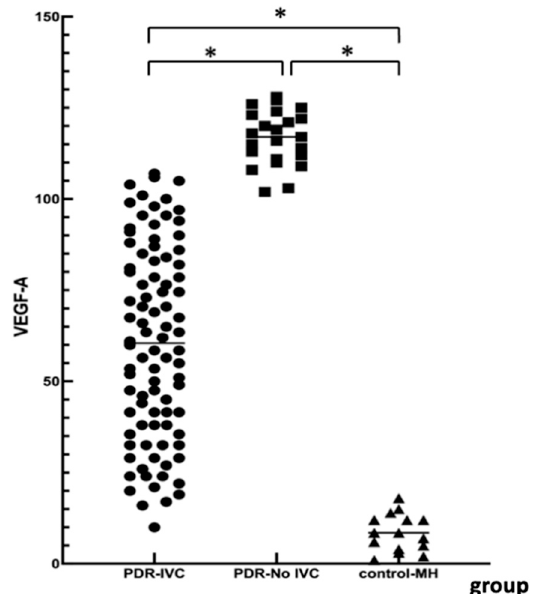
Figure 1. VEGF-A level in vitreous cavity between different groups. PDR: proliferative diabetic retinopathy; PDR-IVC: PDR patients with intravitreal injection of conbercept + pars plana vitrectomy; PDR-No-IVC: PDR patients with pars plana vitrectomy only; Control-MH: control group was patients with macular holes. * p value < 0.05.